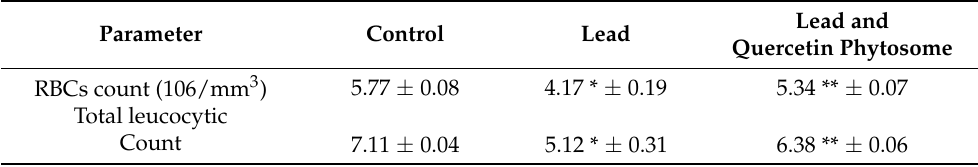
Table 1. Hematological parameters in rats exposed to lead, and rats exposed to lead and given quercetin phytosome, compared to the untreated control